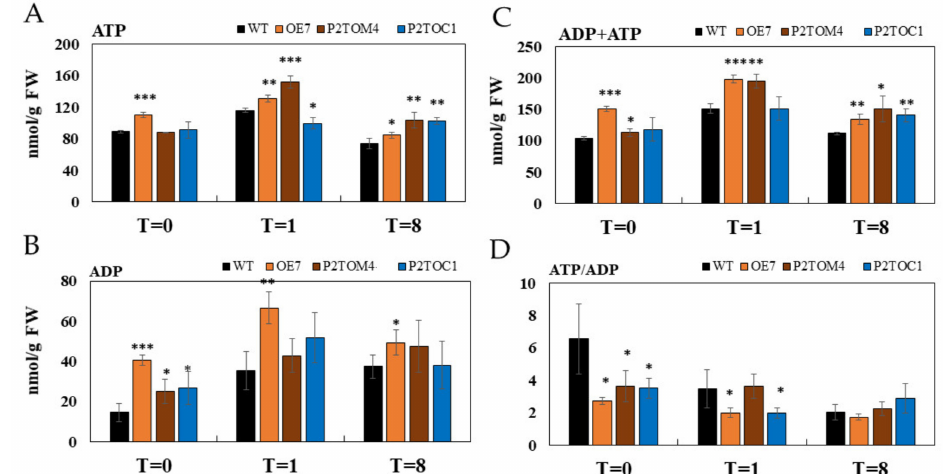
Figure 4. Altered adenosine phosphate levels in leaves of transgenic lines. ( A ) ATP content, ( B ) ADP content, ( C ) ADP + ATP content, and ( D ) ATP/ADP ratio. T = 0, 1, 8 represent end of night, 1 h of illumination after darkness, and 8 h of illumination (midday). Data were calculated by means of three biological replicates. Significant differences between transgenic lines and WT are indicated by asterisks (* p < 0.05, ** p < 0.01, *** p <